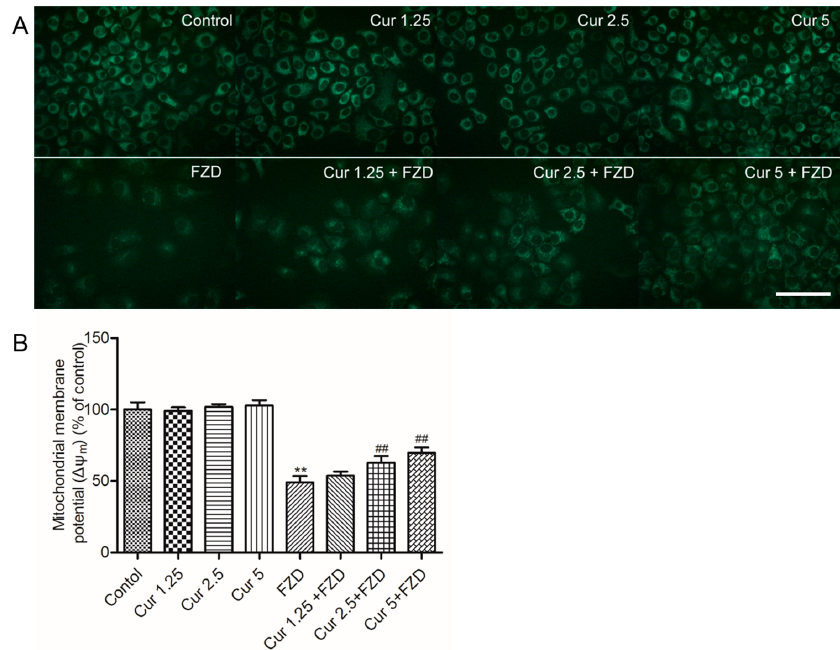
Figure 3. Curcumin reduces FZD induced the loss of mitochondrial membrane potential ( Δψ m ) in L02 cells. ( A ) The changes of Δψ m were observed under a fluorescence microscope after stained with 10 µg/mL Rhodamine 123. Bar = 50 µm; ( B ) The average fluorescent intensities from for five independent microscopic fields were analyzed using Image Pro Plus 5.0 software (National Institute of Mental Health, Bethesda, MD, USA). The reduction of Rhodamine 123 fluorescence indicated loss of mitochondrial membrane potential. ** p < 0.01, compared to the negative control group; ## p < 0.01, compared to the FZD alone treatment group.